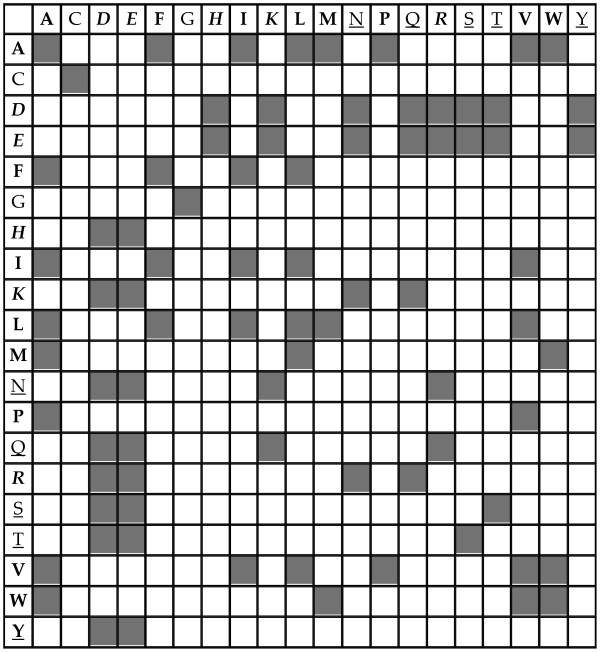
Selection rules for predicted pair of residues. Filled squares represent pairs that are allowed. The hydrophobic residues are in bold, hydrophilic residues in italic, hydrogen donor/acceptors are underlined.